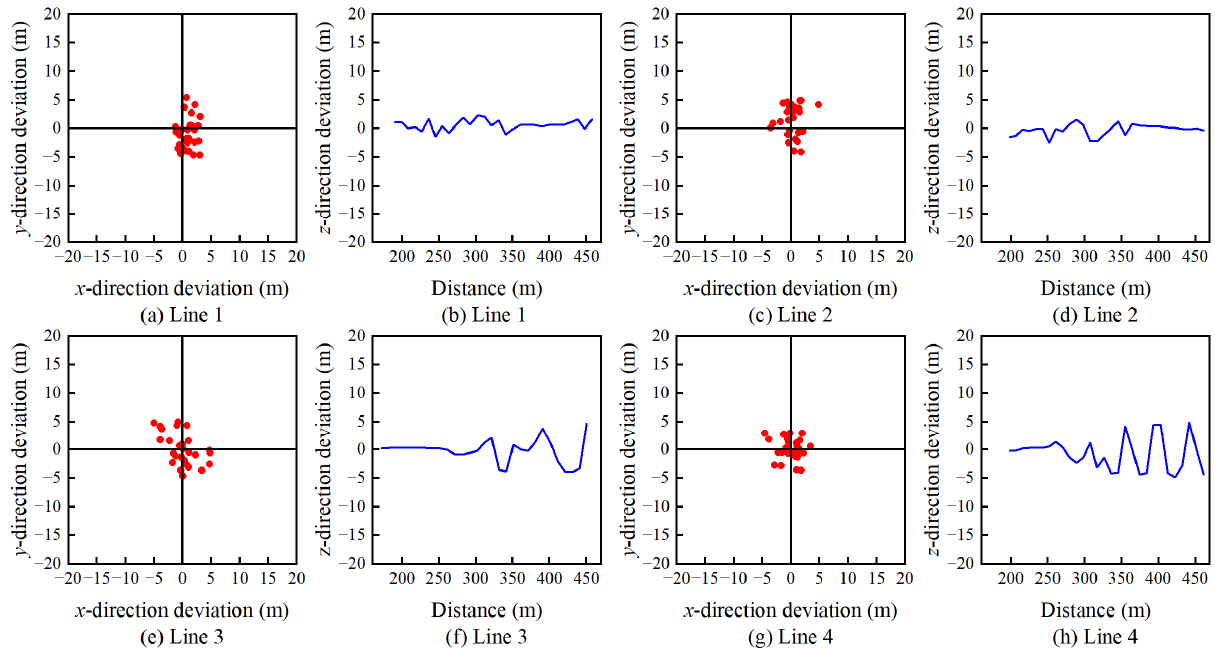
Table 3. Results of obstacle’s location.